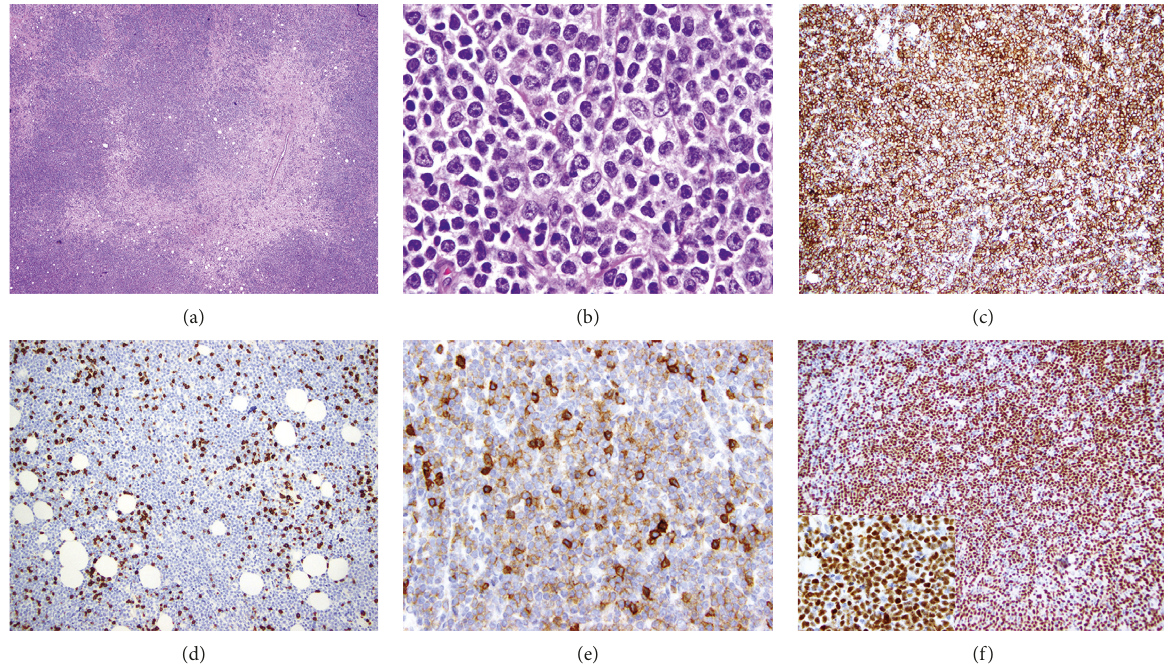
Figure 1: Case 1: lymph node biopsy showing relapsed splenic marginal zone lymphoma with prolymphocytic transformation and acquired CD5 (dim) and cyclin D1 (diffuse, strong) expression. Lymphoma cells consist of both small lymphoid cells with condensed nuclear chromatin, nuclear membrane irregularities, and monocytoid features and transformed cells with prolymphocytic features including intermediate to large size, more abundant cytoplasm, and prominent nucleoli (a, b). Lymphoma cells expressed CD20 (c), were negative for CD3 (d), a subset expressed dim CD5 (e), and cyclin D1 expression was diffuse and strong (f). (a and b) Hematoxylin and eosin staining, (a) 100 times magnification, (b) 500 times magnification, (c, d, and f) 200 times magnification, (e) 400 times magnification, and inset in (f) 1000 times